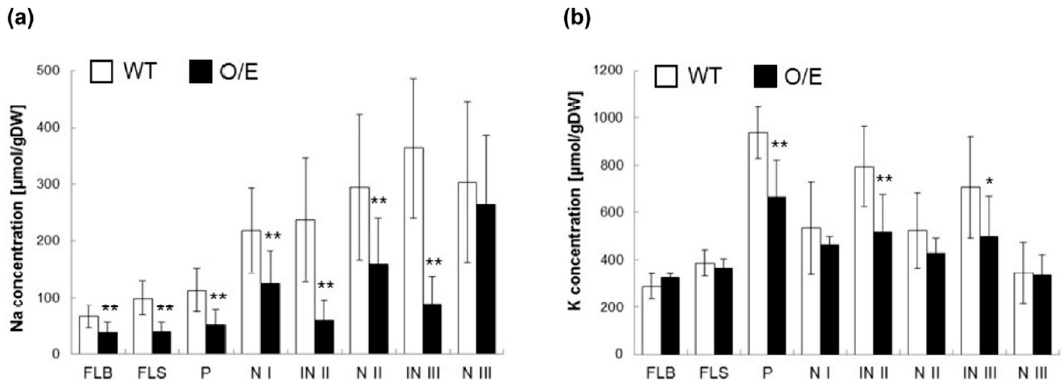
Figure 7. Measurements of Na and K concentrations using salt-stressed O/E and WT plants, which were in the reproductive growth stage. O/E and WT plants were grown in the same pot filled with the paddy filed soil, and, when the plants started heading, salt stress was imposed by gradually increasing the NaCl concentration in the tap water from 25 to 100 mM for more than a month. ( a ) Na concentrations in tissues of flag leaves and stems of O/E and WT plants ( n = 12, ±SD); ( b ) K concentrations in the same tissues as in ( a ) ( n = 12, ±SD). FLB, FLS, P, N I, IN II, N II, IN III, and N III represent, respectively, the flag leaf blade, the flag leaf sheath, peduncle, node I, internode II, node II, internode III, and node III. Asterisks indicate significant differences between O/E and WT plants (Student’s t -test; * p < 0.05, ** p < 0.01).